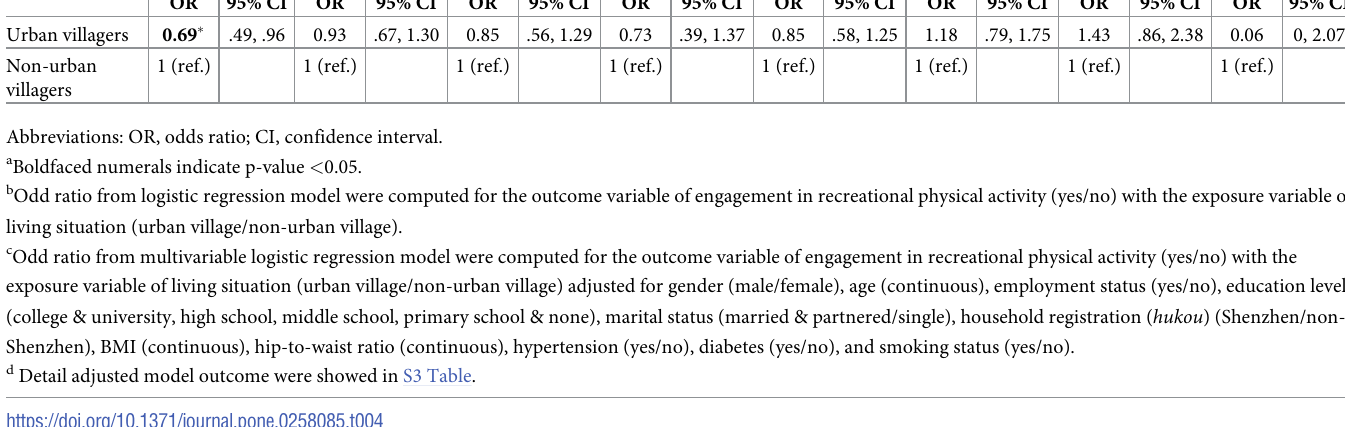
Table 4. Odd ratios of average hours spend in sedentary behaviors per day between urban villagers and non-urban villagers. 2–4 hours vs. < 2